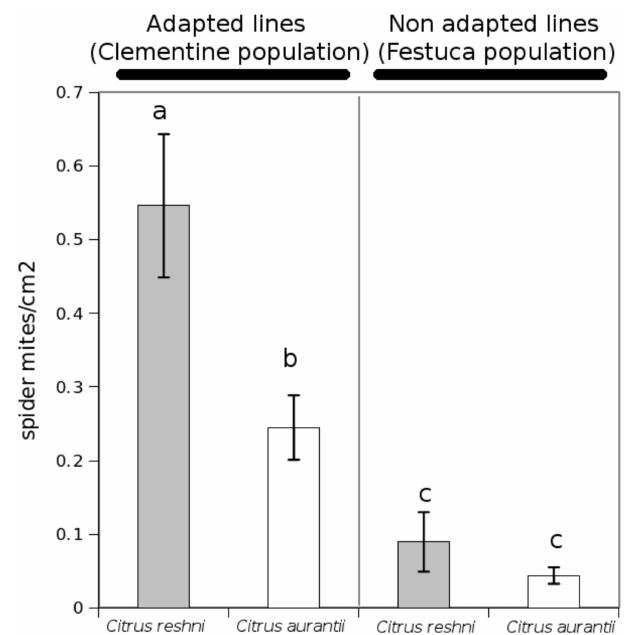
Figure 1. Plant resistance to adapted and non-adapted lines of T. urticae . Two different citrus genotypes, C. reshni and C. aurantium , are susceptible and resistant, respectively, against T. urticae when this mite was originally reared on citrus (Clementine) leaves for more than 30 generations. However, both citrus genotypes are strongly resistant to the infestation of mite lines grown in F. arundinacea leaves for more than 30 generations. Three-month-old plants were infested with five adult females mites per plant, and the number of adults was scored 14 days after